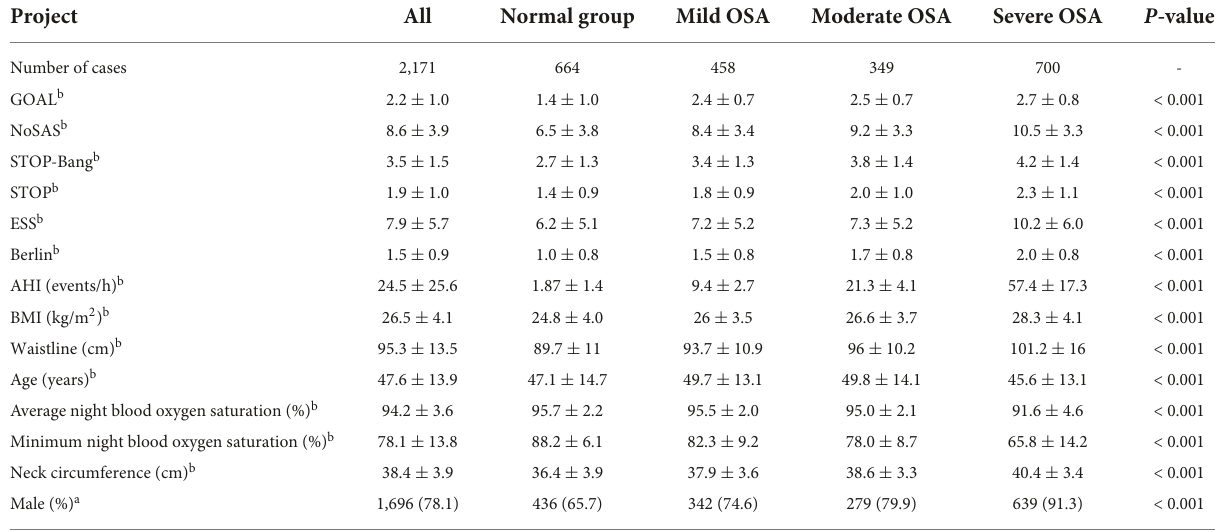
TABLE 1 Basic data of patients in each group and scores of six scales.